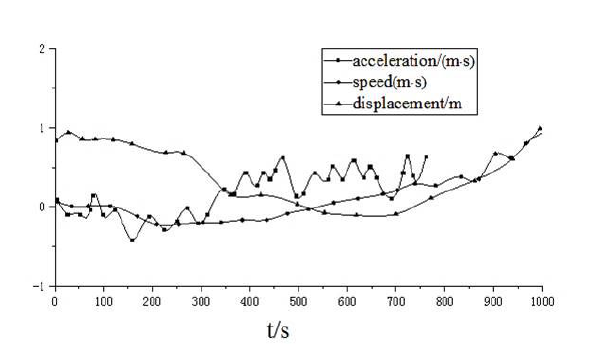
Figure 11: Simulated outcomes for speed curve